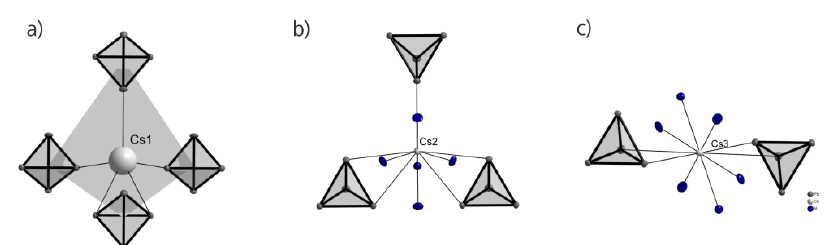
Figure 2. Comparison of the cationic coordination spheres of [E 4 ] 4− (E = Sn, Pb) clusters in Na 4 Sn 4 ·11.5NH 3 ( a ); Rb 4 Sn 4 ·2NH 3 ( b ); NaPb ( c ); Rb 4 Pb 4 ·2NH 3 ( d ) and Cs 4 Pb 4 ·5NH 3 ( e ); probability factor: 50%; dark grey marked cations occupy special Wyckoff positions.